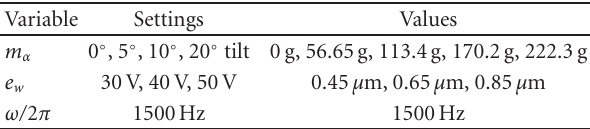
Table 2: Test parameters for experimental and numerical